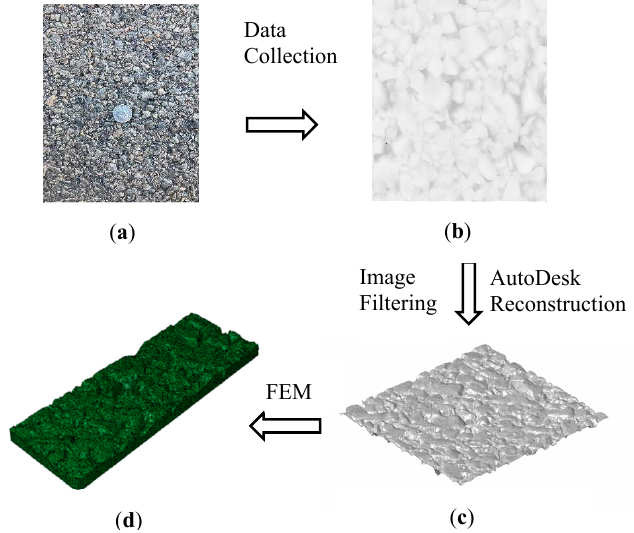
Figure 7. Reconstruction of 3D texture surface for FEM simulation: ( a ) Field Data; ( b ) LS-40 Range Data; ( c ) Re-constructed Data; ( d ) Pavement FEM Model.